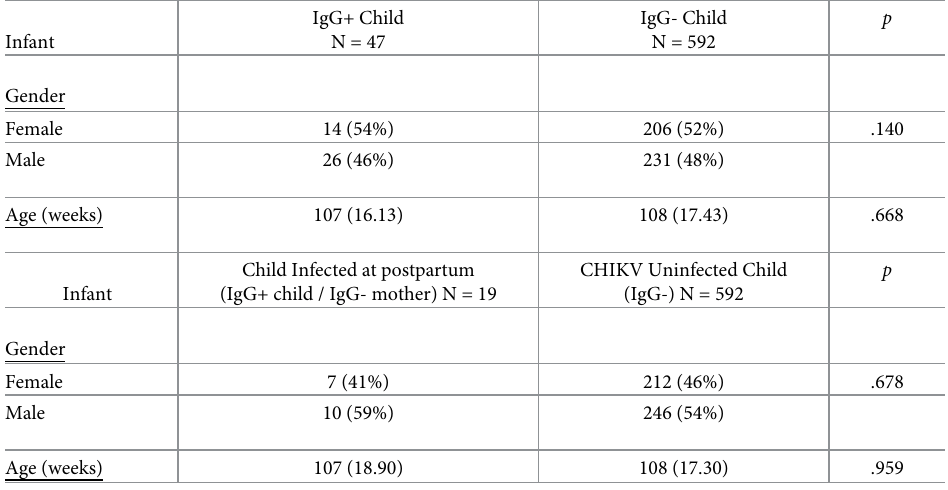
Table 1. Sample characteristics for CHIKV Infected vs. Uninfected Children: Means and